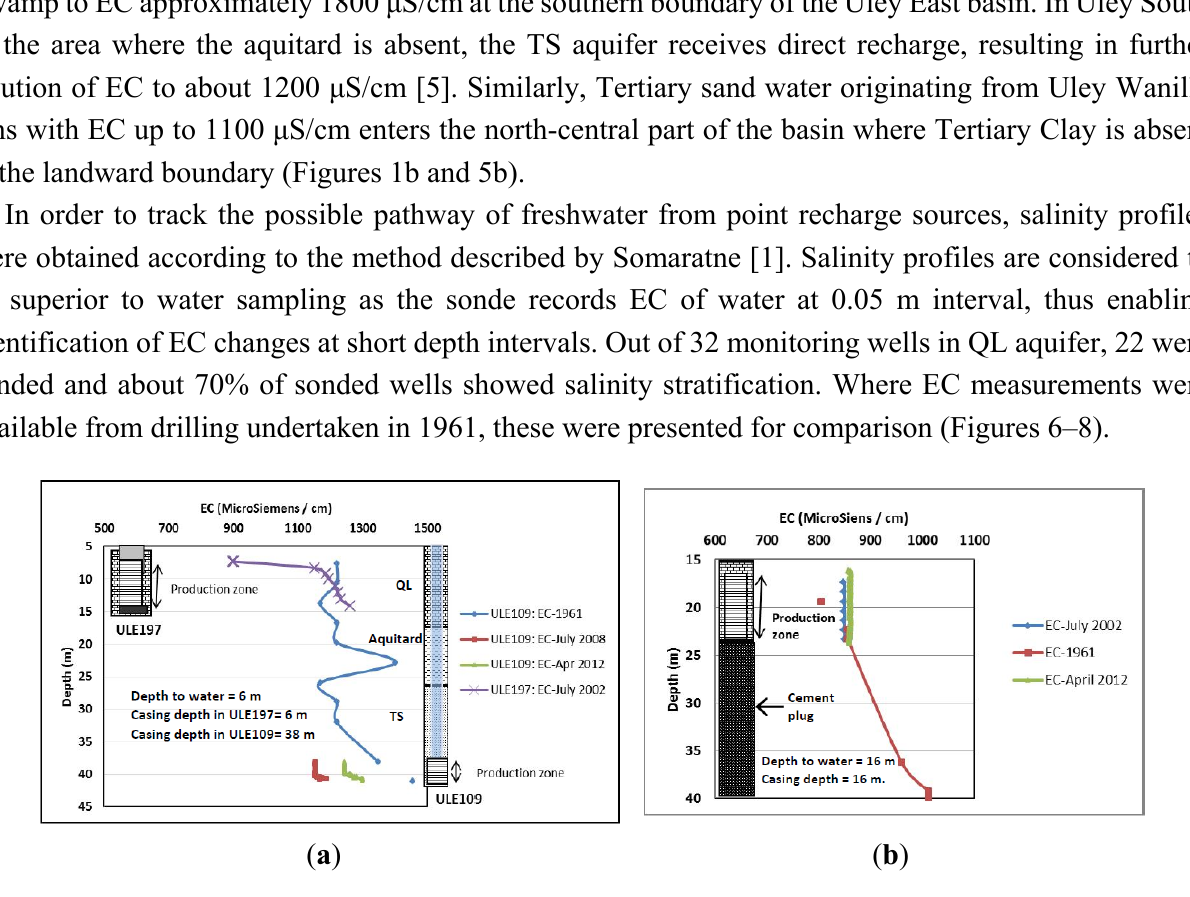
Figure 6. Effect of Tertiary Sand water leaking into QL aquifer on salinity stratification ( a ) ULE109 and ULE 197; ( b ) ULE139.